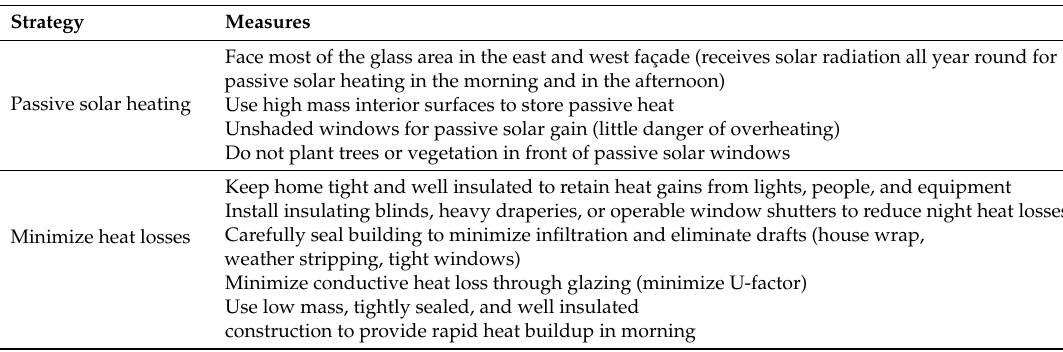
Table 3. Design strategies for the clime in Quito ‐ Ecuador.